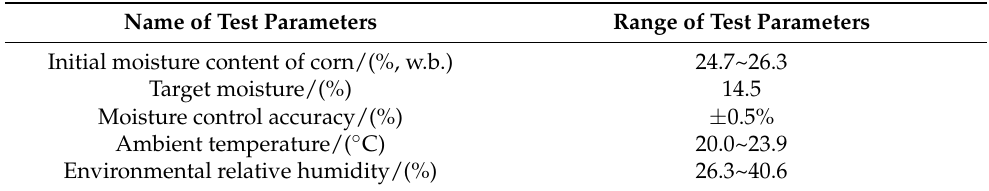
Table 12. Test parameters.